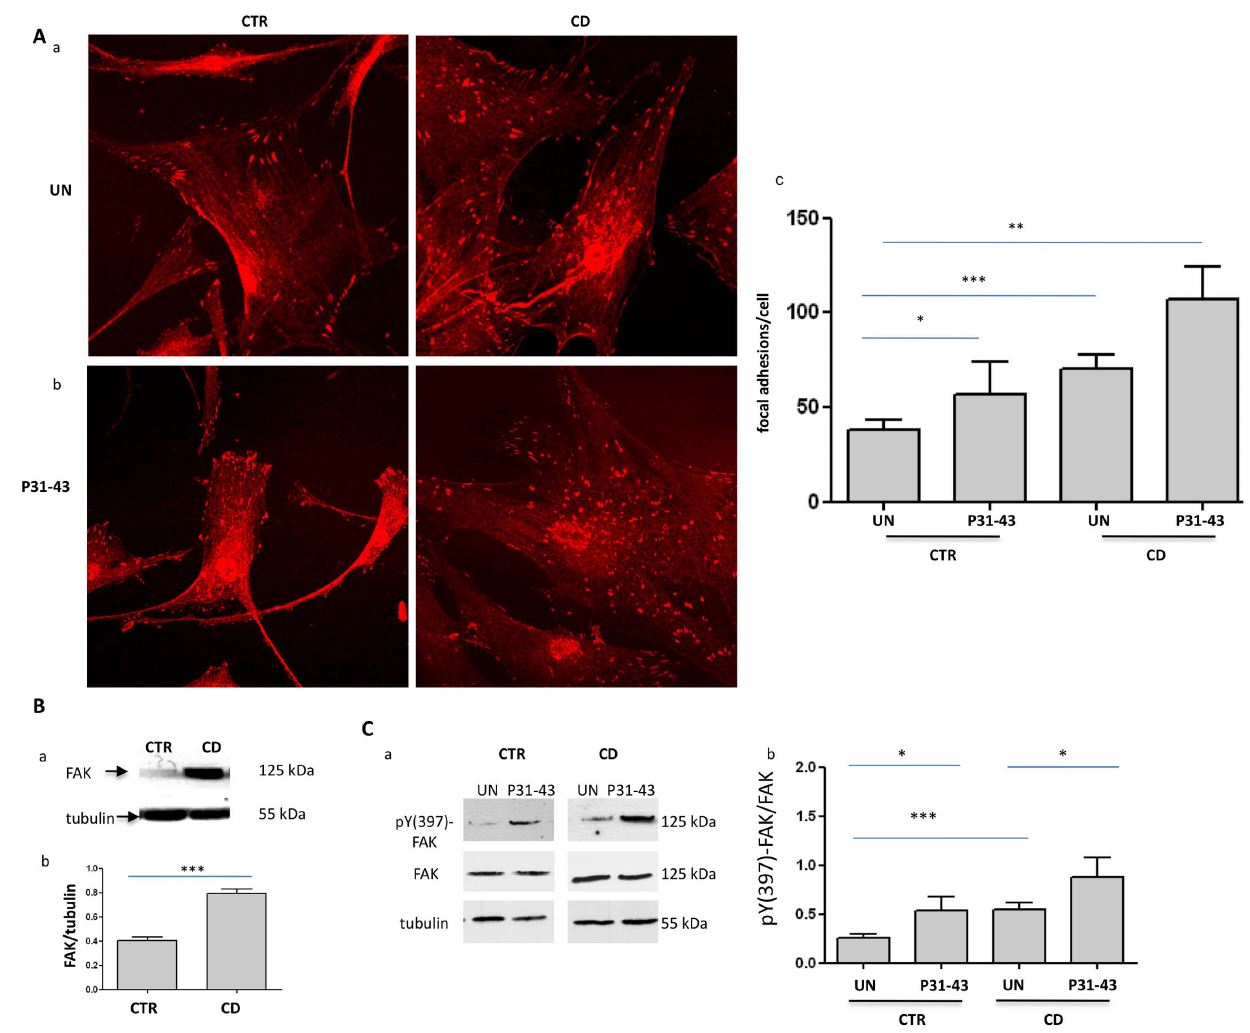
Figure 3. Analysis of the focal adhesion number and FAK levels in CD and controls fibroblasts before and after P31-43 treatment. A. Increase of focal adhesion number in CD, as revealed through FAK staining before and after P31-43 treatment. a) Confocal immunofluorescence images of fibroblasts from CD patients and controls stained with antibodies against FAK. Representative fields. b) Confocal immunofluorescence images of fibroblasts stained with antibodies against FAK from CD patients and controls treated with P31-43 for 30 min. Representative fields. c) Statistical analysis of the number of FAK-positive focal adhesions per cell before and after P31-43 treatment. Focal adhesions of 30 fibroblasts of several fields from 3 independent experiments with 6 patients and 6 controls were counted. Columns represent the means, and the bars represent the standard deviations. Student’s t -test. *= p , 0.05; **= p , 0.01; ***= p , 0.001. B. FAK protein levels are increased in fibroblasts from CD patients with respect to the controls. a) Western blot analysis of fibroblast protein lysates from controls and CD patients. The upper line is stained for FAK, and the lower line is stained for tubulin. Representative experiment. b) Densitometric analysis of western blots stained for FAK in fibroblasts from 5 CD patients and 5 controls. FAK levels were normalized to the tubulin levels. Columns represent the means, and the bars represent the standard deviations. Student’s t -test. ***= p , 0.001. C. FAK phopshorylation is increased in CD fibroblasts and is further increased after P31-43 treatment for 30 9 . a) Western blot analysis of fibroblasts proteins lysates from controls and CD patients treated or not with P31-43. The upper line is stained for pY- FAK, the middle line is stained for FAK and the lower line is stained for tubulin. Representative experiment. b) Densitometric analysis of western blots stained for pY-FAK and FAK in fibroblasts from 5 CD patients and 5 controls. pY-FAK levels were normalized to the FAK levels. Columns represent the means, and the bars represent the standard deviation. Student’s t -test. *= p , 0.05; ***= p , 0.001.